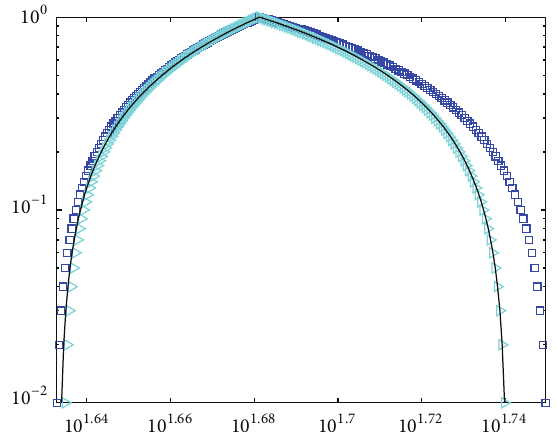
Figure 3: Compare the proposed solution ̃𝑥 −,𝑙,𝑢 1 (⊳), ̃𝑥 +,𝑙,𝑢 1 (◻) with (̃𝑥 ) ∙∙ ) ,(̃𝑥 −,𝑙 ) ( — ),(̃𝑥 −,𝑢 1 𝐷 ( 1 𝐴 (̃𝑥 ) (−) 1 𝐴